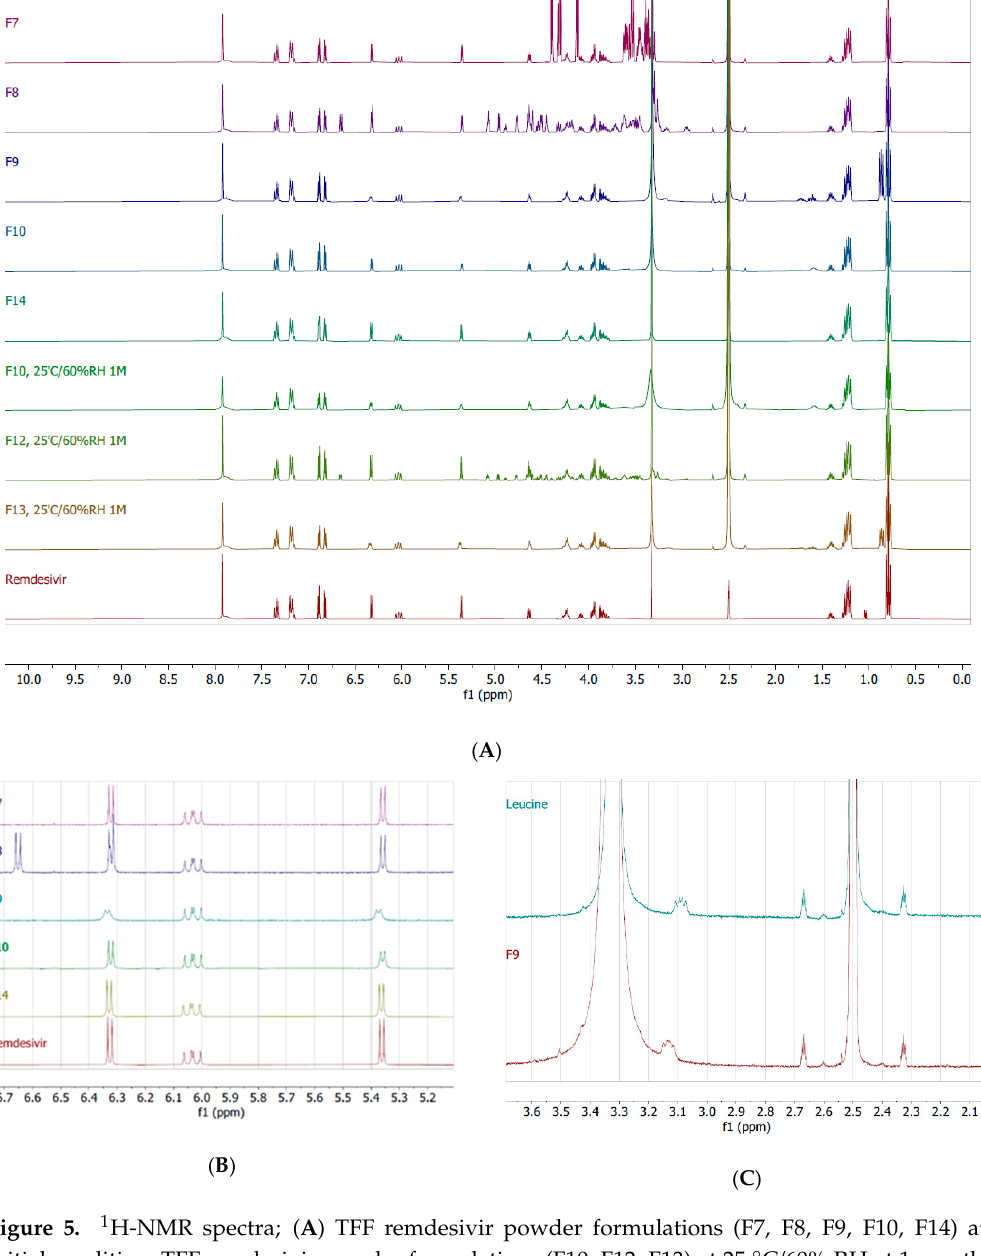
Figure 6. XRD diffractograms of F10, F12, and F13 after storage at 25 °C/60% RH. 3.4.3. Aerosol Performance after Storage The aerosol performance of F10, F12 and F13 was analyzed after one month of storage at 25 °C/60% RH (Table 3 and Figure 7). Overall, MMAD and FPF < 5 µm (of recovered dose) of F10, F12, and F13 was in the range of 1–2 µm and 74–83%, respectively (Table 3). Although MMAD was slightly decreased 050010001500 20002500 3000 3500 5